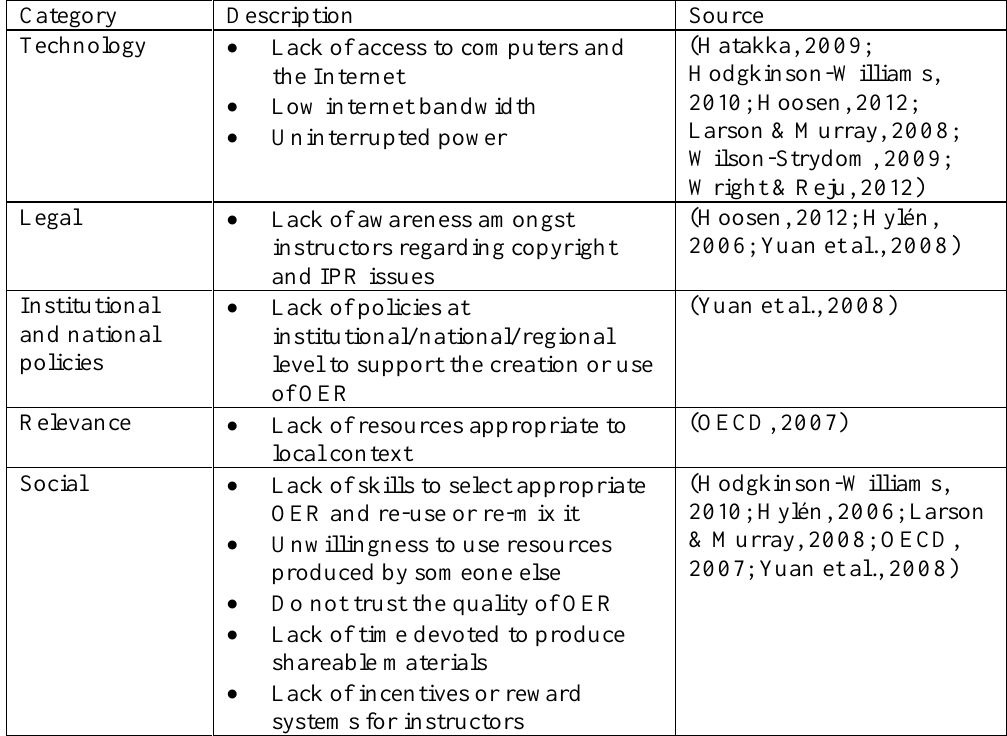
Perceived Barriers to Use of OER in Sub-Saharan